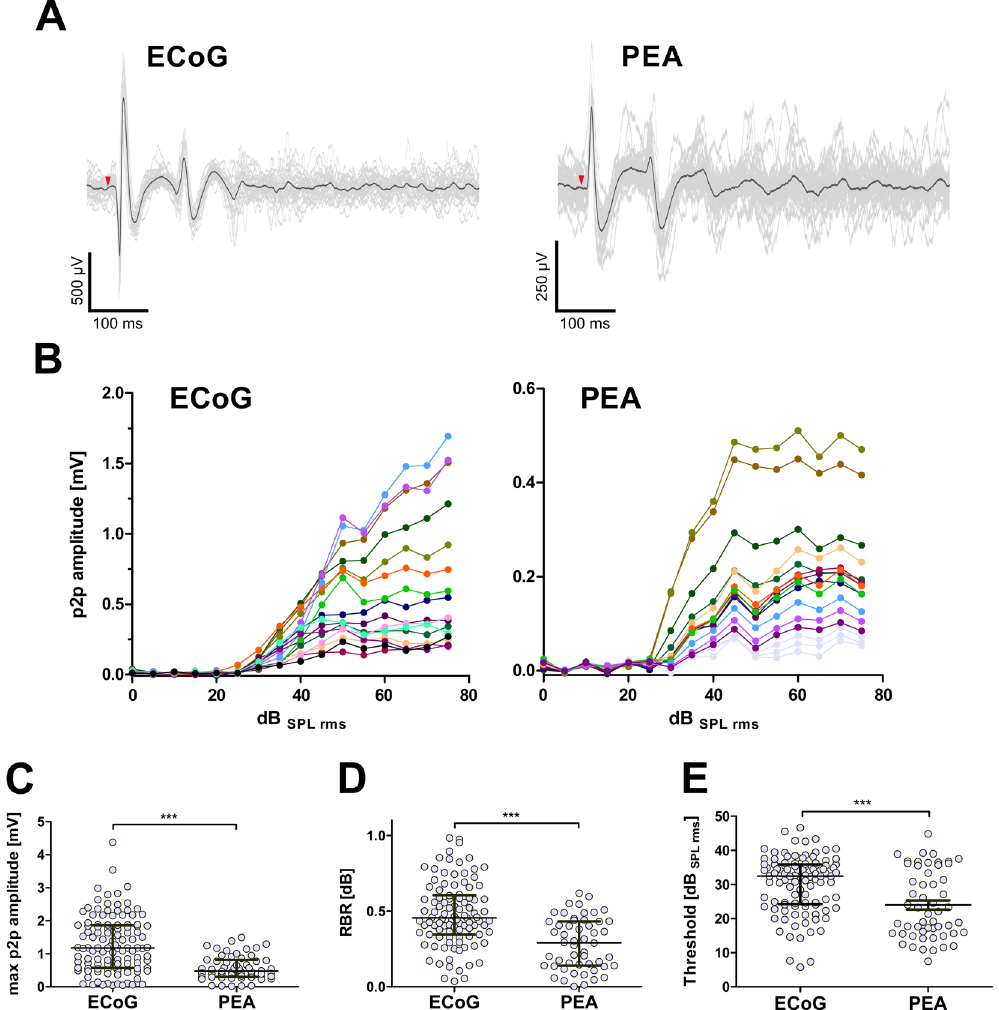
Figure 2. The new ECoG grid enabled recordings of evoked LFP responses similar to conventional penetrating multi-electrode arrays. ( A ) Examples of evoked responses to a 100 ms broad-band stimulus for an ECoG grid and a penetrating multi-electrode array (PEA) from the same cortical recording. Given are 30 single sweeps (thin grey lines) and an averaged signal (thick black line). Stimulus onset is indicated (red arrow head). ( B ) Input-output functions of LFP peak-to-peak (p2p) amplitudes in response to a broad-band stimulus. The colors represent different recording positions; the three deepest PEA contacts (excluded from further analysis) are indicated in light grey. The amplitudes at the penetrating electrode (PEA) are significantly smaller than those at the ECoG grid (C and D). ( E ) The response thresholds at ECoG grid contacts was slightly higher (i.e. worse) than those recorded at the penetrating electrode (PEA) contacts. ( C ) The maximal peak to peak (p2p) amplitude at ECoG grid contacts was significantly higher than those recorded at the penetrating electrode (PEA) contacts. ( D ) The response-background ratio (RBR) at 20 dB above response threshold was significantly higher at ECoG than at PEA contacts. ( C – E ) Given are individual data (dots) and medians with IQR (lines). Mann-Whitney U test: *** p <